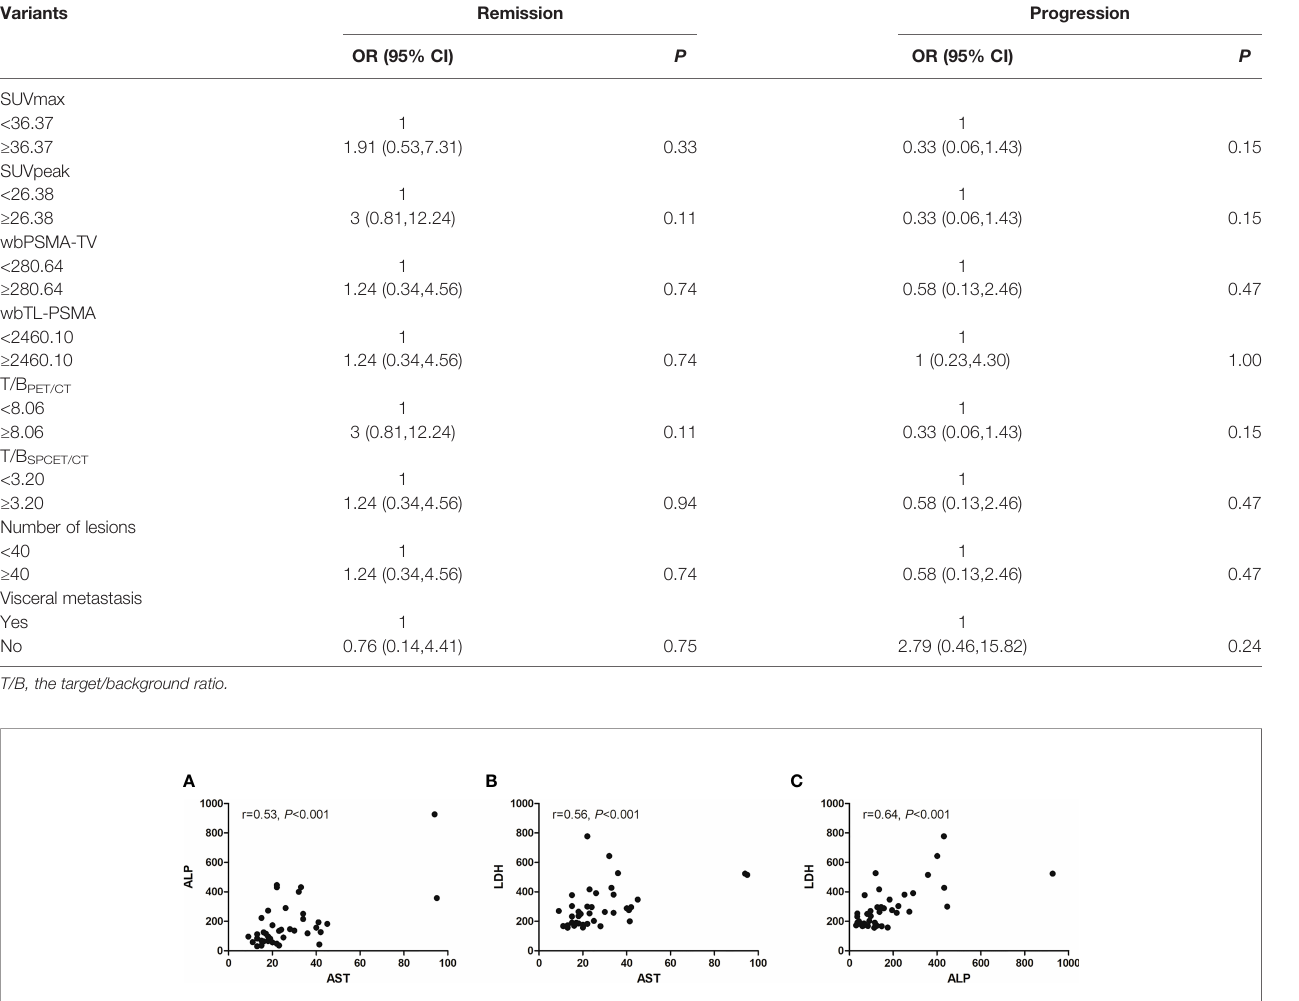
FIGURE 7 | Scatter diagram showing correlation between three baseline serum biomarkers. (A) AST and ALP, (B) AST and LDH, and (C) ALP and LDH.